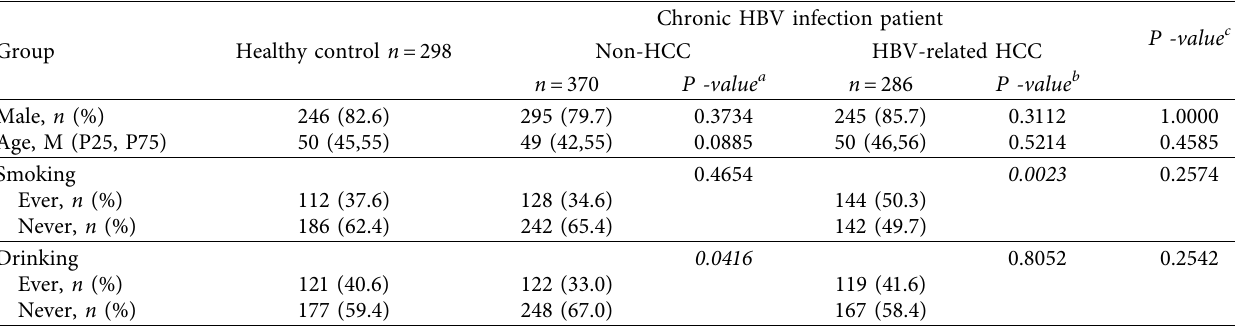
Table 2: Baseline characteristics of 954 study subjects.